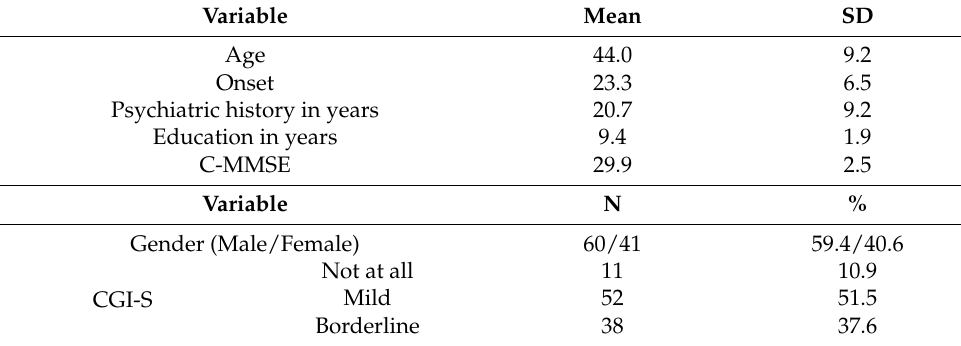
Table 1. Characteristics of the participants ( n =